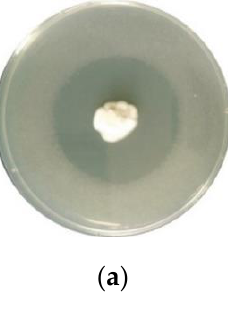
Figure 5. Formation of solubilization zone owing the activity of Paecilomyces lilacinus . ( a ) ZnO (arrow—clear zone of solubilization); ( b ) ZnNO 3 (arrow—discrete zone of solubilization); ( c ) ZnSO 4 (arrow—pale zone of solubilization); ( d ) phosphorous solubilization (arrow—violet-purple color of medium as solubilization area). strated by the formation of transparent zone surrounding fungal colonies (Figure